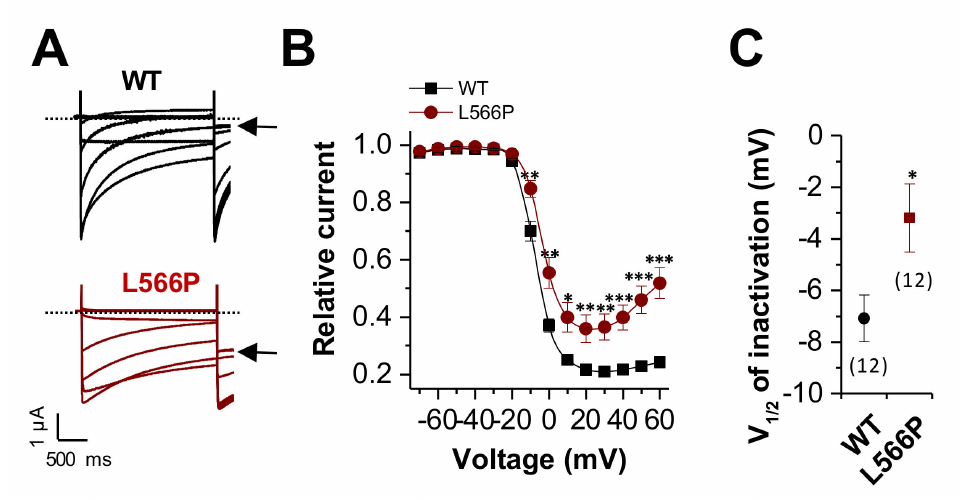
Figure 3. Reduced and shifted voltage dependence of inactivation of Ca V 1.2 L566P . ( A ) Representative current traces of Ca V 1.2 WT (black) or Ca V 1.2 L566P (red) recorded from a holding potential of − 80 mV. Voltage was stepped to potentials ranging from − 70 to +60 mV in 10 mV increments for 2 s, followed by a step to +10 mV. The sweep time interval was 30 s. ( B ) Steady-state inactivation curves derived by plotting the prepulse potential against the initial current recorded at the test pulse at 10